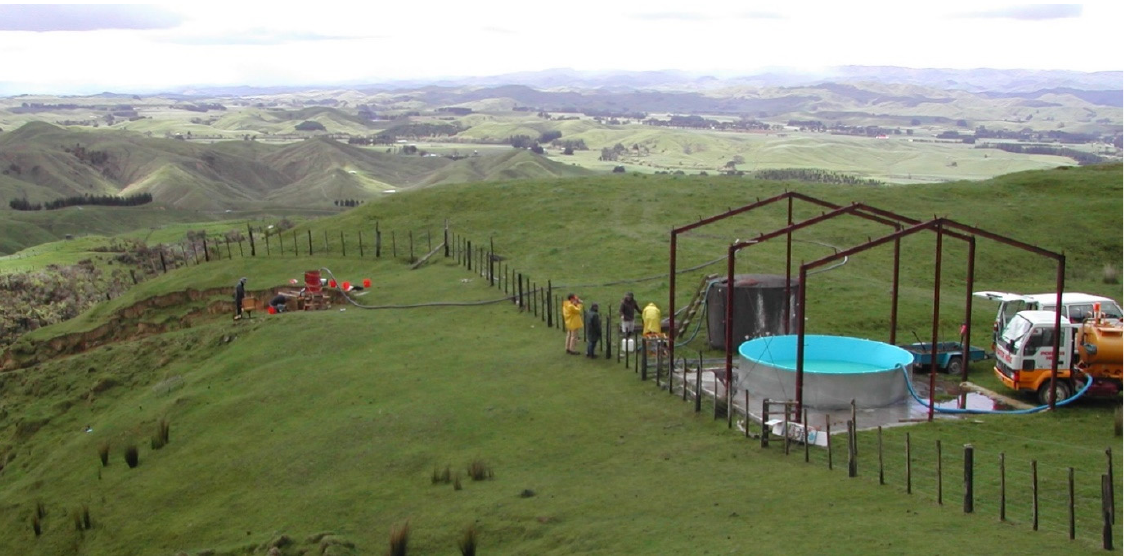
Figure 2. Experimental site at the Ballantrae Hill Country Research Station near Woodville, New Zealand.